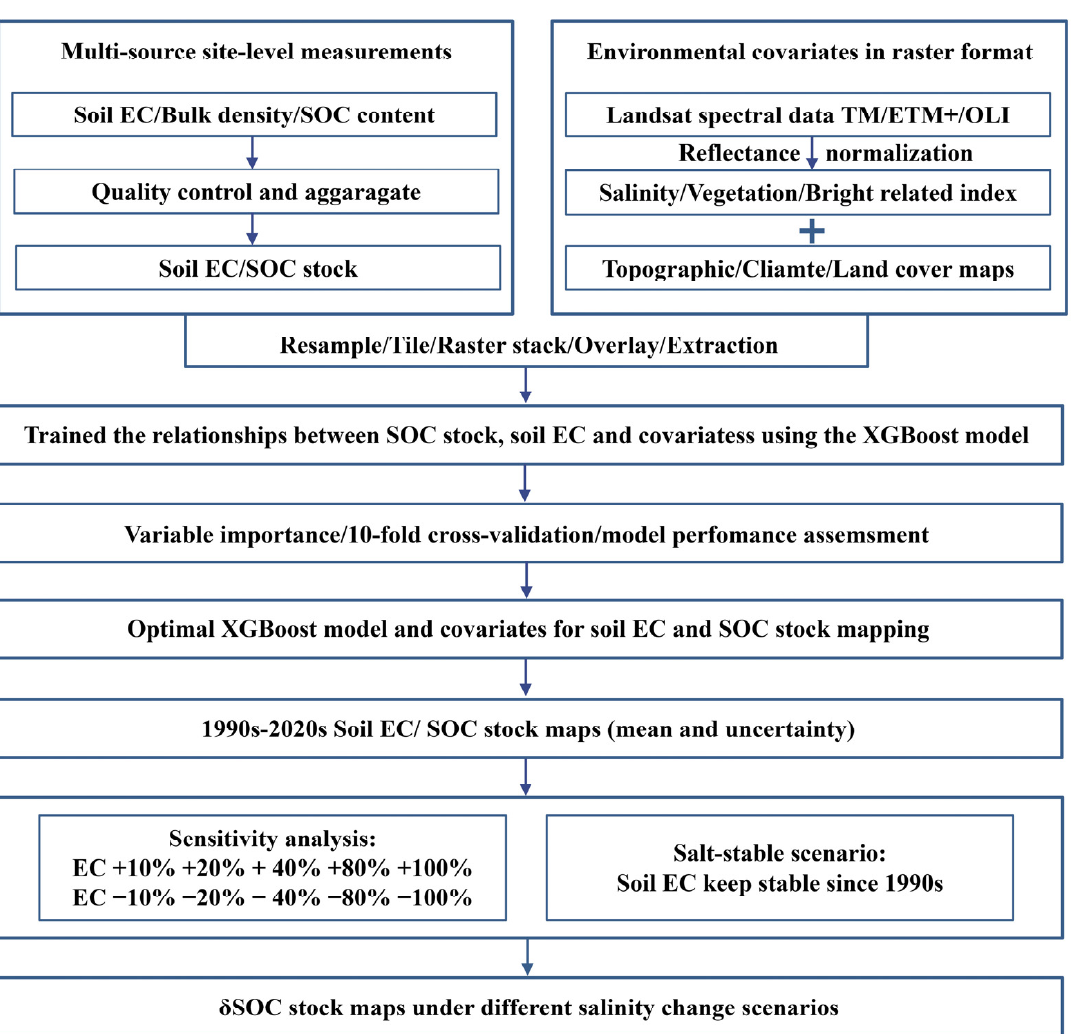
Figure 2. Flowchart of the methodology for this study.